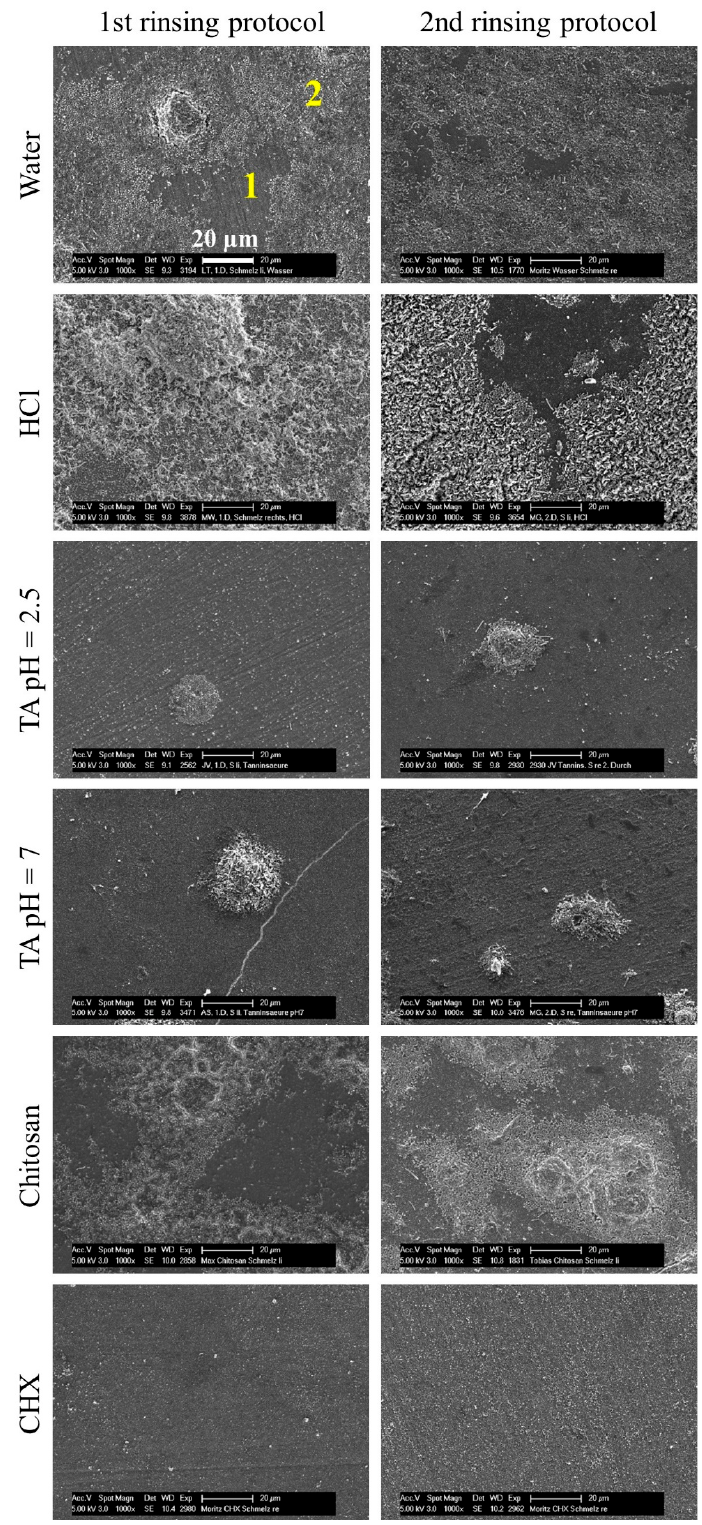
Figure 6. Representative scanning electron micrographs of specimens in 1000-fold magnification. Bovine enamel specimens were attached to upper jaw splints that were carried by subjects ( n = 6) for 48 h. In the first protocol, rinsing occurred 5 times and, in the second protocol, 4 times with di ff erent experimental solutions. Micrographs show specimens covered by a biofilm that consists of the pellicle (1) and bacteria (2). HCl = hydrochloric acid, TA 2.5 = tannic acid (pH = 2.5), TA 7 = tannic acid (pH = 7) and CHX =